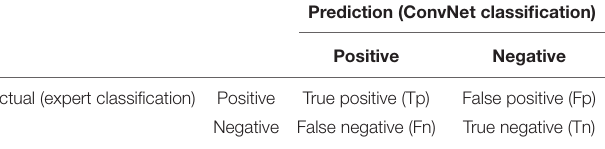
TABLE 1 | Confusion matrix for a classification task.